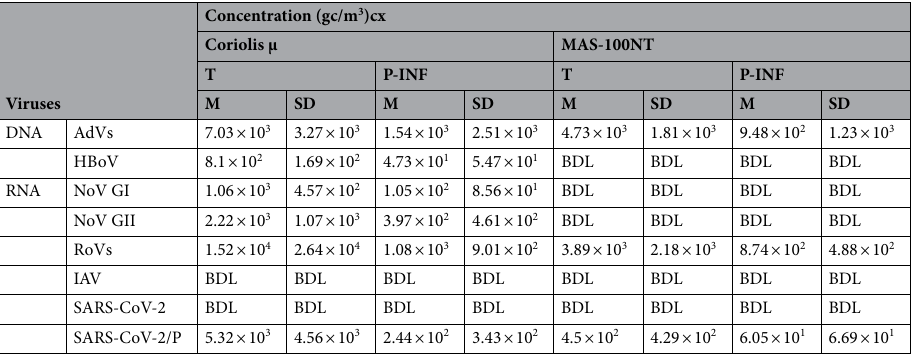
Table 3. The concentrations of DNA and RNA viruses (gc/m 3 ) in air samples collected using Coriolis μ impinger and MAS-100NT impactor. T total concentration of viruses, P‑INF concentration of potentially infectious viruses, M arithmetic mean value, SD standard deviation, BDL below detection limit, AdVs adenoviruses, HBoV human bocavirus, NoV GI Norwalk virus genogroup I, NoV GII Norwalk virus genogroup II, RoVs rotaviruses, IAV influenza A virus, SARS‑CoV‑2 severe acute respiratory syndrome coronavirus 2, SARS‑CoV‑2/P presumptive SARS-CoV-2 positive/other coronaviruses